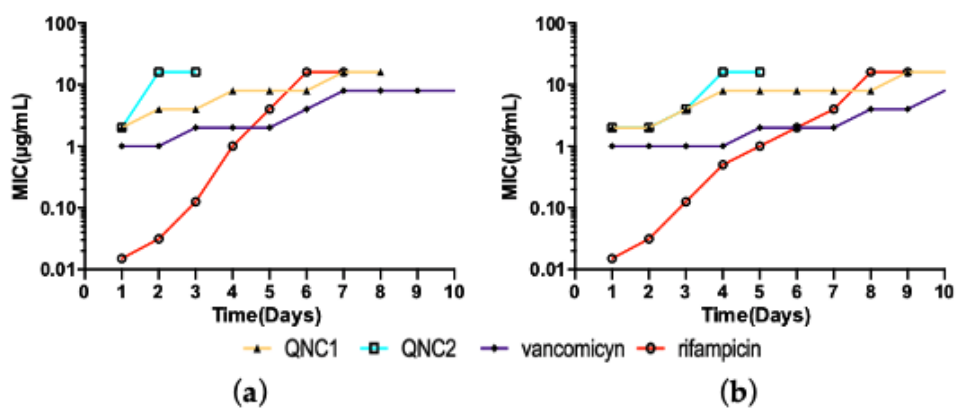
Figure 3. Daily changes in MIC during serial passage assay of QNC1 and QNC2 against ( a ) MSSA ATCC ® 29213; ( b ) MRSA clinical isolates ISP-213. Rifampicin and vancomycin were used as con- trols.